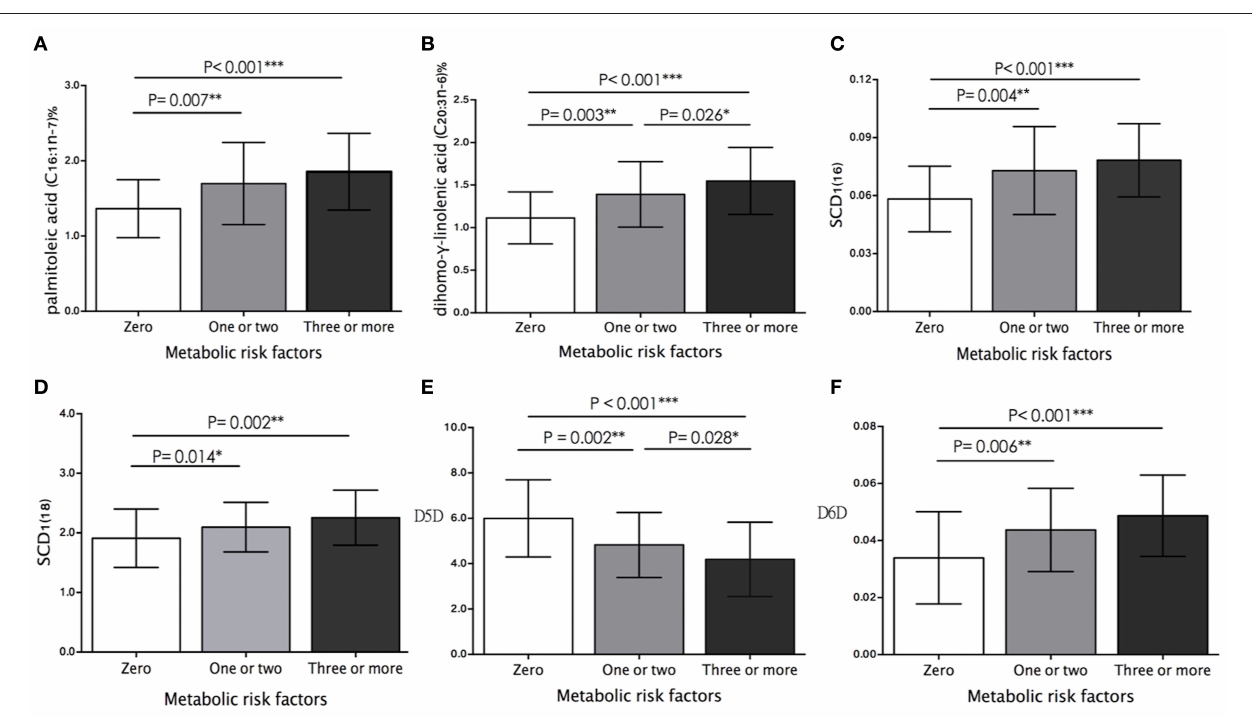
FIGURE 1 | Comparison of plasma (A) palmitoleic acid proportion, (B) dihomo- γ -linolenic acid proportion (DGLA), and estimated activity of (C) SCD1(16), (D) SCD1(18), (E) D5D, and (F) D6D between study participants who had zero, one or two, and more than three metabolic risk factors. Histograms were prepared using mean values and SD. The differences between study groups are based on ANOVA test with multiple comparison analysis. Significance levels: * P < 0.05, ** P < 0.01, *** P < 0.001. (38). Our findings imply that increased palmitoleic acid (16:1n- 7) proportion, a product related to SCD1(16) activity, not